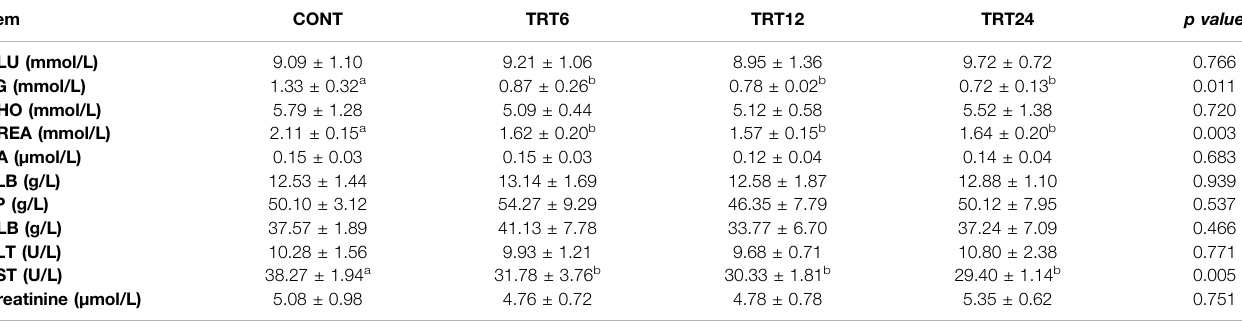
TABLE 7| Effectsofalfalfa-mixed silagefermentation material(AMSFM)onantioxidantindexes ofchestand legmusclesfrommeat geese.Controlgeese (CONT)werefeda basal diet, whereas TRT6, TRT12, and TRT24 were fed a basal diet supplemented with 6, 12, or 24% AMSFM, respectively. Team CONT